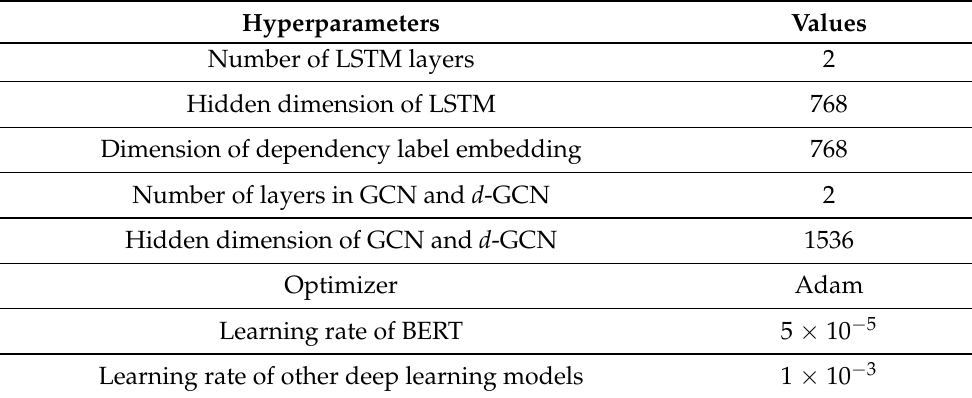
Table 1. Hyperparameters used in experiments.